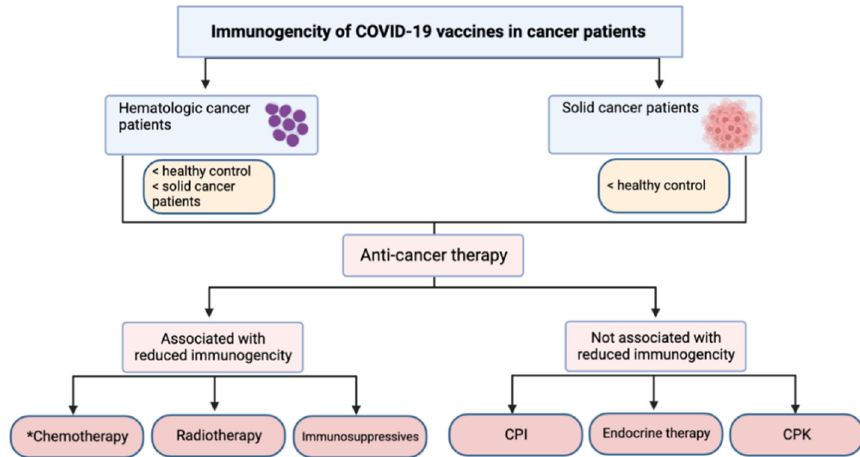
Figure 3. Immunogenicity of COVID-19 vaccines in cancer patients with hematologic or solid cancers and the effect of different types of anti-cancer therapy on the immunogenicity. Immunogenicity was measured in most of the studies by rates of seropositivity and/or antibody titers. * Only chemotherapy was reported to reduce both rates of seropositivity and antibody titers.